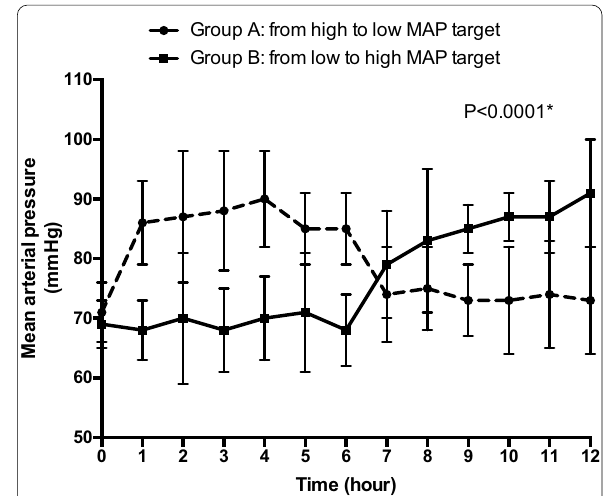
Fig. 3 MAP evolution during the high‑MAP target period and the low‑MAP target period. * P values for the within‑subject comparison of MAP using a multivariate repeated‑measures analysis of variance